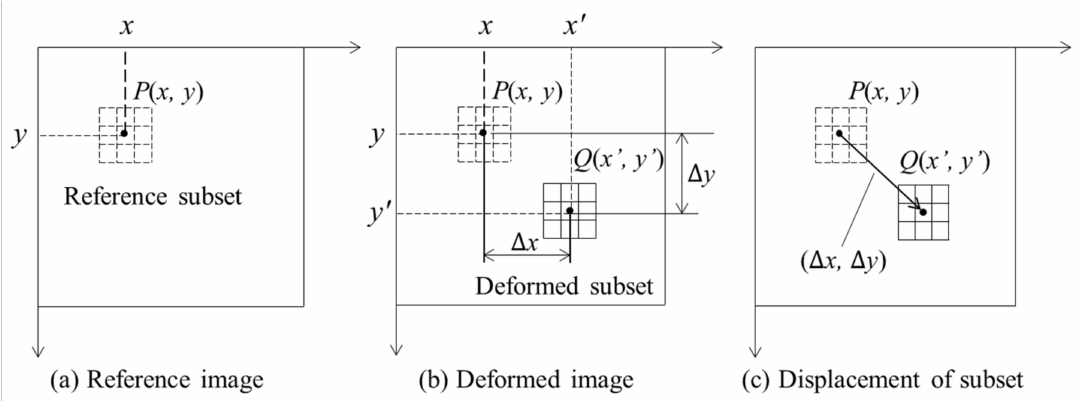
Figure 1. Tracking point movement by DIC method.